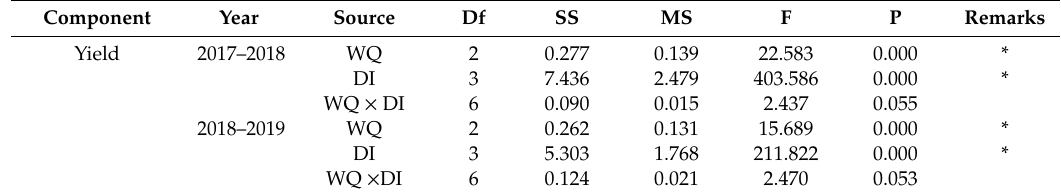
Table 5. Output of the two-way ANOVA for yield per plant under four irrigation scenarios (DI), three water qualities (WQ) and their interactions (WQ × DI).